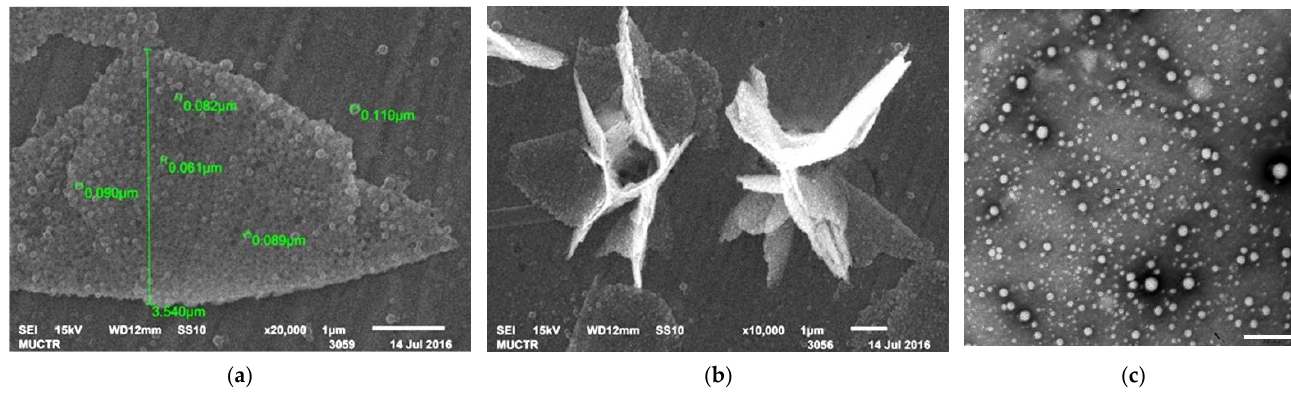
Figure 1. ( a ): SEM image of PLGA-Cou6 nanoparticles (non-PEGylated); ( b ): nanoparticles clusters (broader view); scale bar 1 μm; ( c ): PLGA-PEG-Cou6 nanoparticles (scale bar 500 nm).